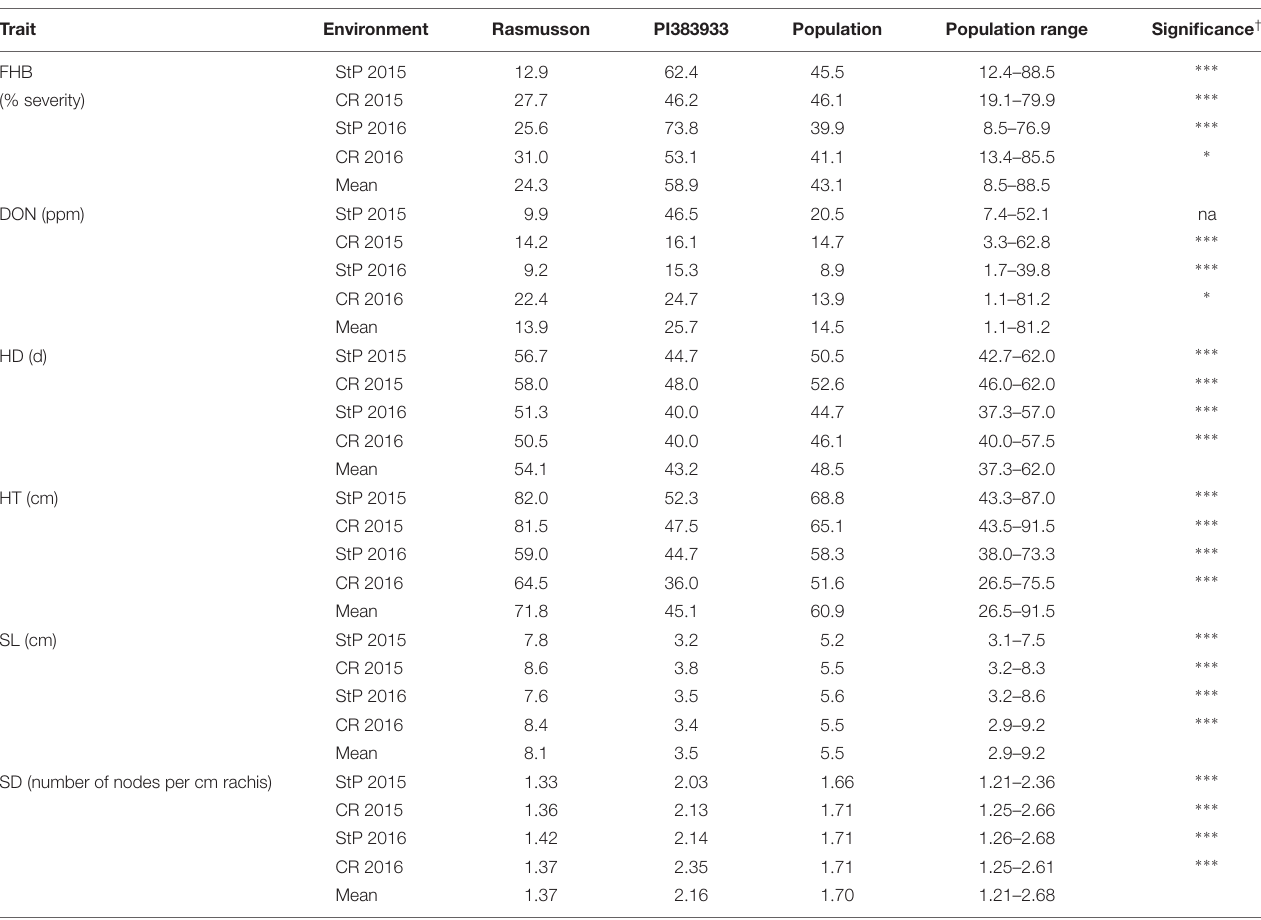
TABLE 1 | Parental means, population means and range, and ANOVA tests of line means in the Rasmusson/PI383933 recombinant inbred line (RIL) population for Fusarium head blight (FHB), deoxynivalenol accumulation (DON), heading date (HD), plant height (HT), spike length (SL), and spike density (SD) in St. Paul (StP) and Crookston